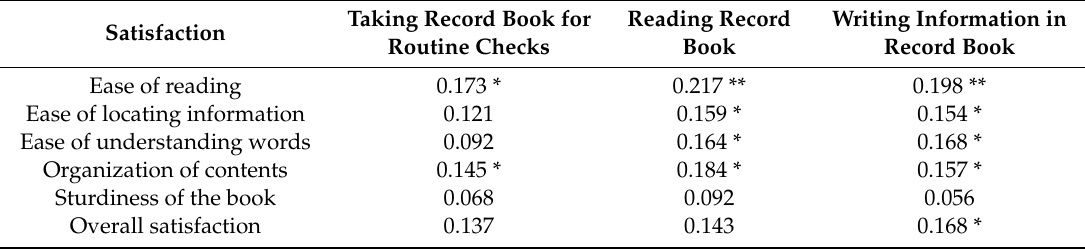
Table 4. Correlation between parent engagement with record book and satisfaction.